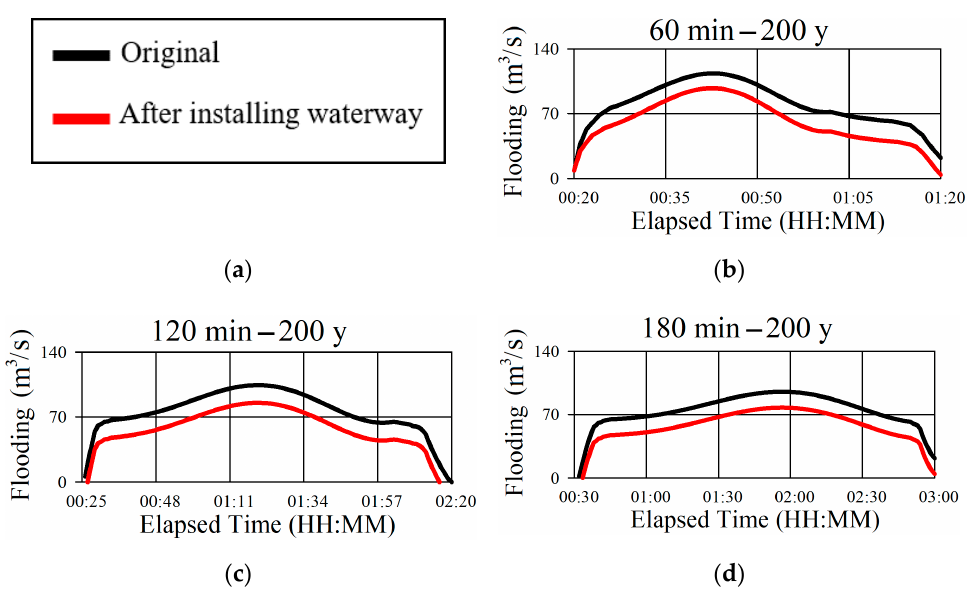
Figure 12. Flooding on the Oncheon River before and after installing the underground waterway (rainfall quantile). ( a ) Legend, ( b ) 60 min–200 year, ( c ) 120 min–200 year, ( d ) 180 min–200 year.